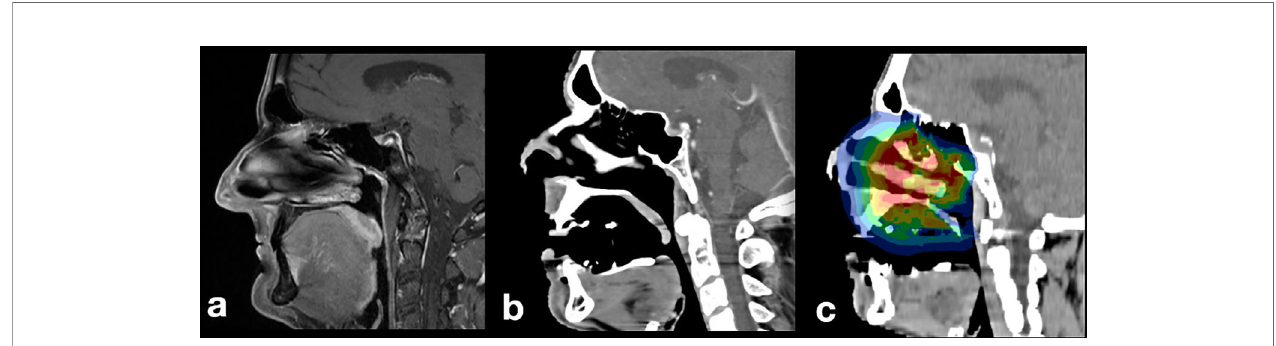
FIGURE 3 | Patient with pleomorphic sarcoma of the nasal sinus: (A) diagnostic MR imaging without TRD, (B) baseline planning CT with incorporated TRD: the tongue is displaced to a caudal position, (C) irradiation plan without involvement of mandibular soft or hard tissues.